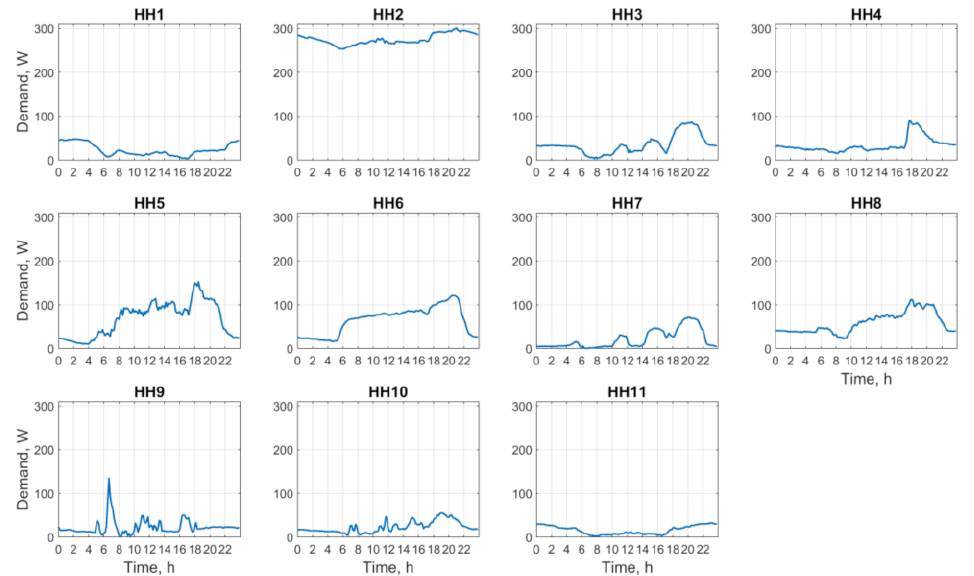
Figure 16. Average load profiles of households for the months of October and November 2020 in the Gilutongan Island solar